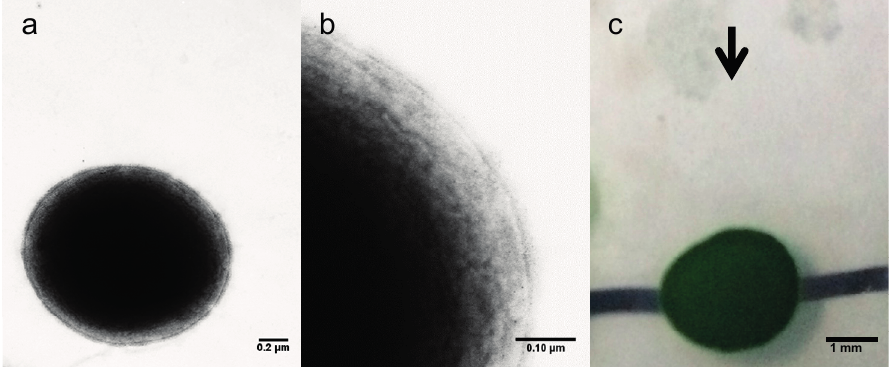
Figure 2. Surface structure and motility of GT-G. ( a , b ) Electron micrograph of negatively stained GT-G cells; ( c ) Phototactic movement of colonies of GT-G. The arrow indicated the direction of lateral light and the black line under the colony shows the initial position before lateral